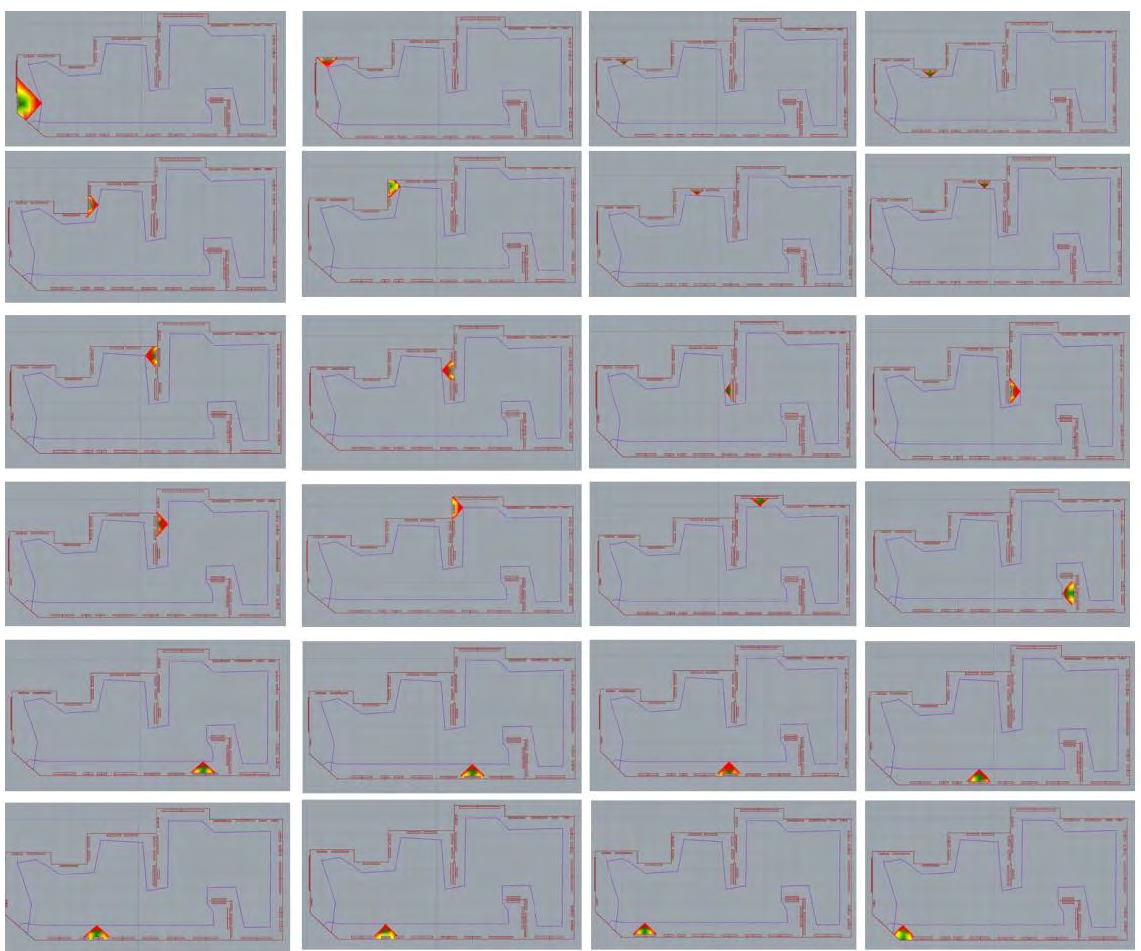
Figure 3. the parametric Visibility Analysis of a certain Visitor in the Exhibition using smart space analyzer plug in